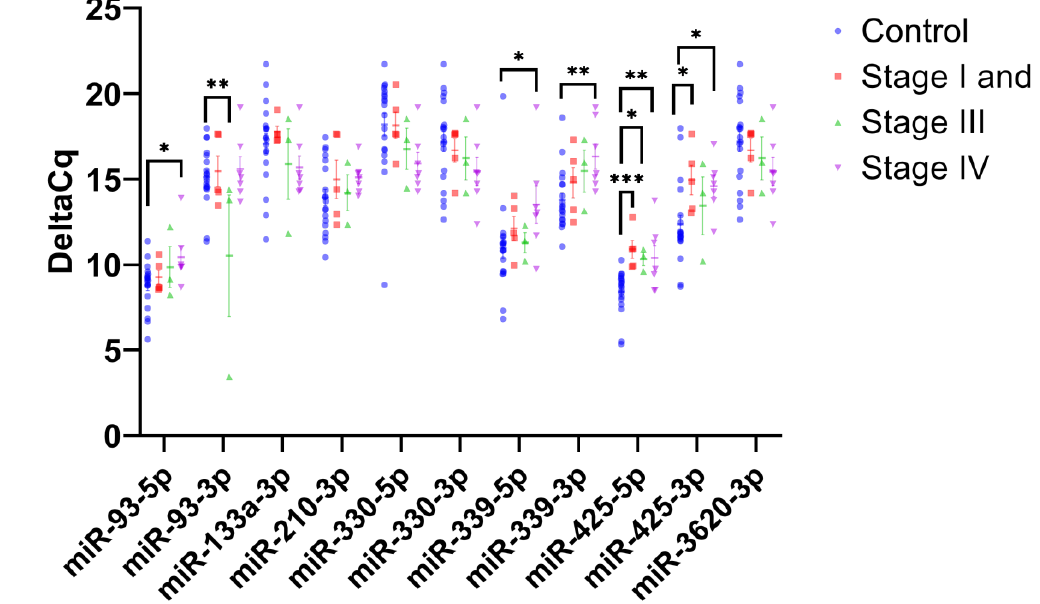
Figure 2. PDAC stage-specific expression levels of plasma exosomal miRNAs. The scatterplot shows the average ΔCq values for 11 mature miRNAs in PDAC samples separated by staging, early stage (stage I and II, N = 5), mid stage (stage III, N = 3) and late stage (stage IV, N = 7), and compared to control samples (N = 19). Student’s t -test was used to establish significance, where *, **, and *** denote p < 0.05, p < 0.01, and p < 0.001, respectively.